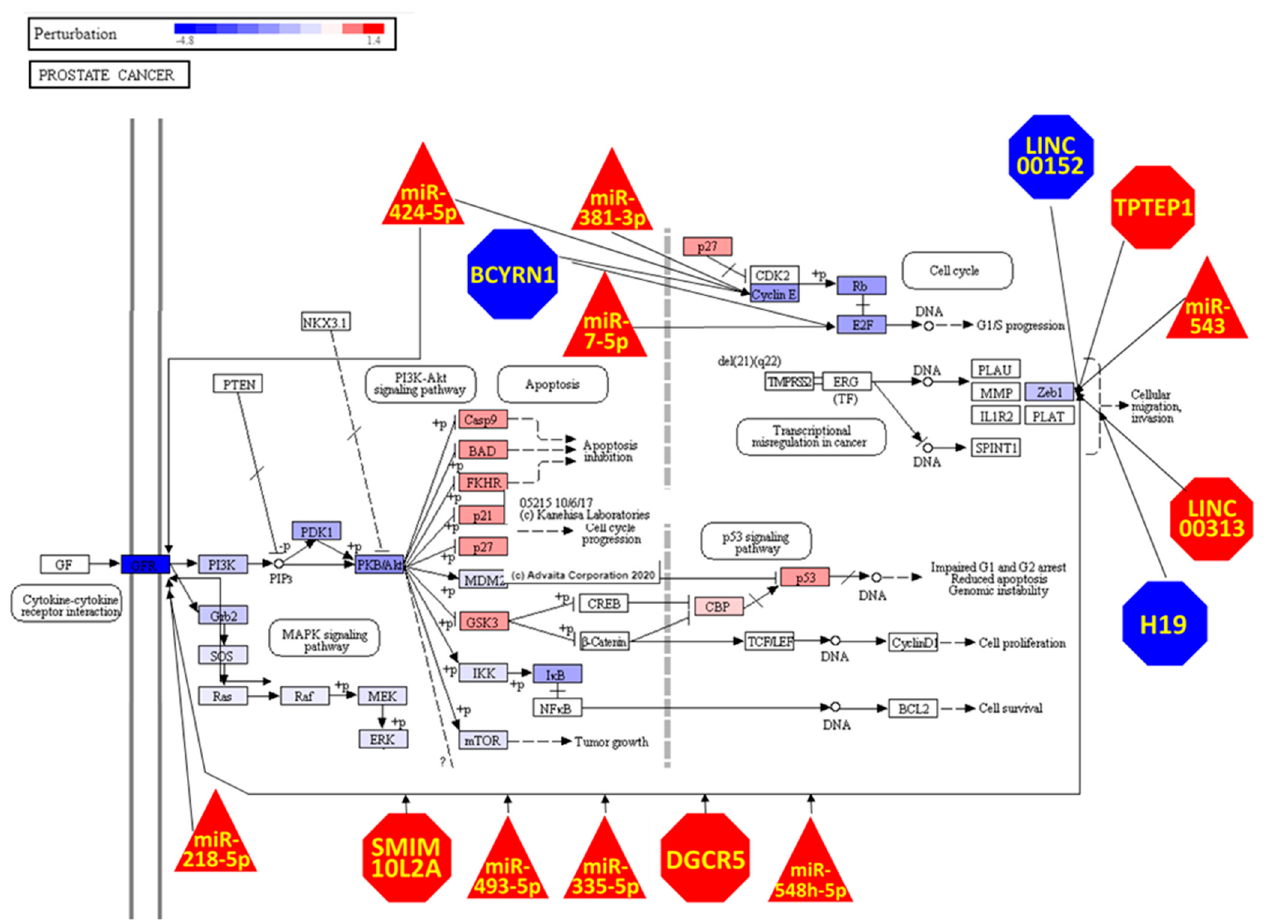
Figure 5. Prostate Cancer KEEG pathway genes being perturbed and regulated by ncRNAs due Cell Senescence. The transcription factor ZEB1 is the target of a large number of ncRNAs. The DE RNA threshold in limma was log 2 Fold Change ≥ |1| and adjusted p-value (FDR) < 0.01. The Prostate Cancer KEGG pathway depiction and impact analysis were generated using iPathwayGuide (Advaita). Blue indicates down-regulated and red up-regulated in senescent cells relative to non- senescent cells. Genes are presented as rectangles, miRNAs as triangles, and lncRNAs as octagons.